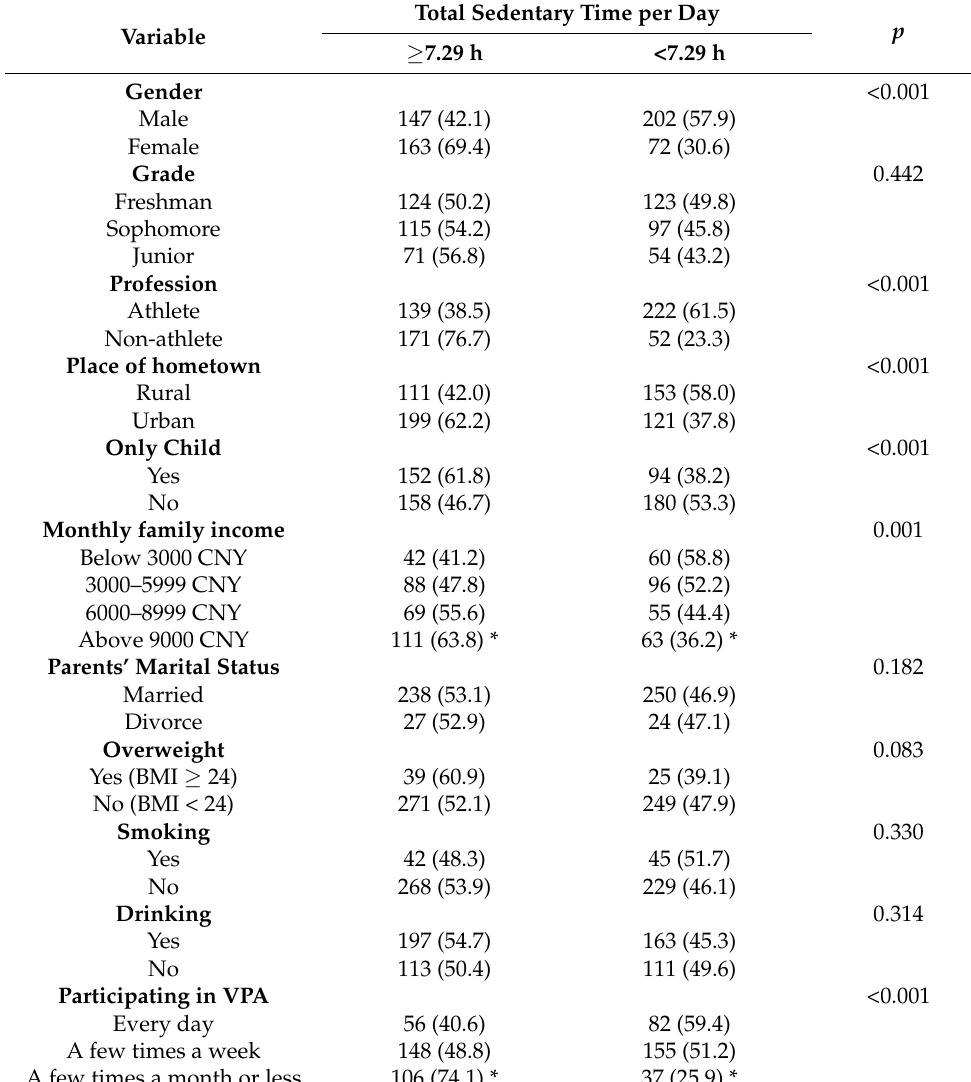
Table 3. Characteristics of the participants by level of total sedentary time, n (%).